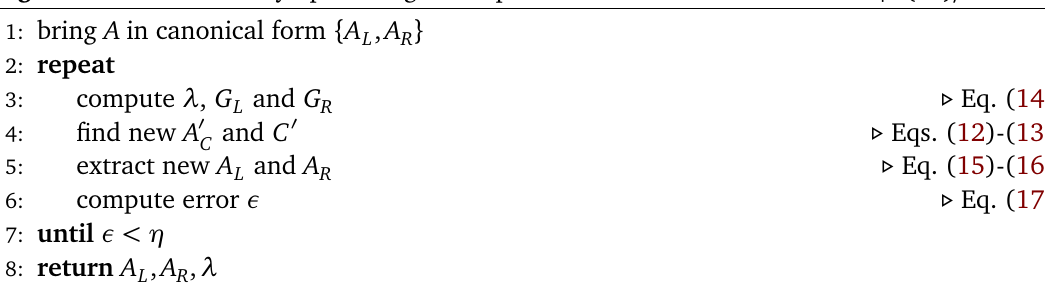
Algorithm 1 Variationally optimizing overlap of uniform MPS with trial state | Ψ ( M )